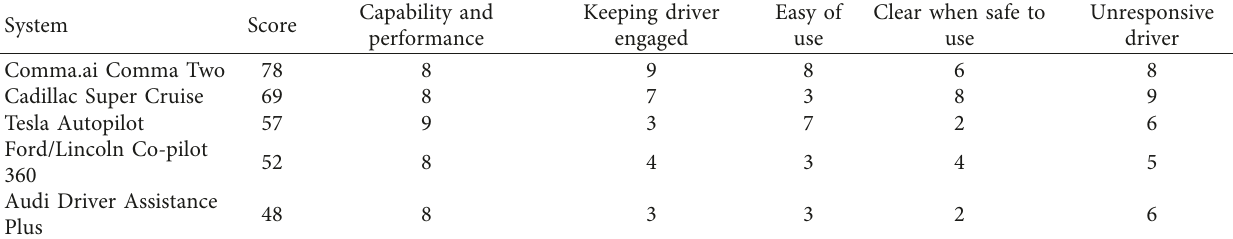
Table 2: Consumer reports top 5 ADASs [43].